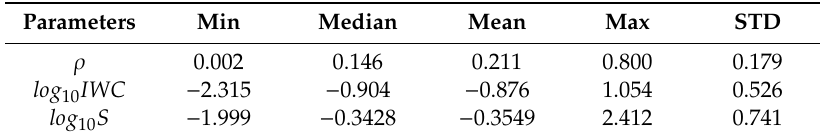
Figure 3. Histograms of snow PSD parameters for total snowfall events: ( a ) the density of snow, 𝜌 (g cm −3 ); ( b ) ice water content, 𝑙𝑜𝑔 10 𝐼𝑊𝐶 ( 𝐼𝑊𝐶 in g m −3 ); ( c ) liquid water equivalent snowfall rates, 𝑙𝑜𝑔 10 𝑆 ( 𝑆 in mm h −1 ).